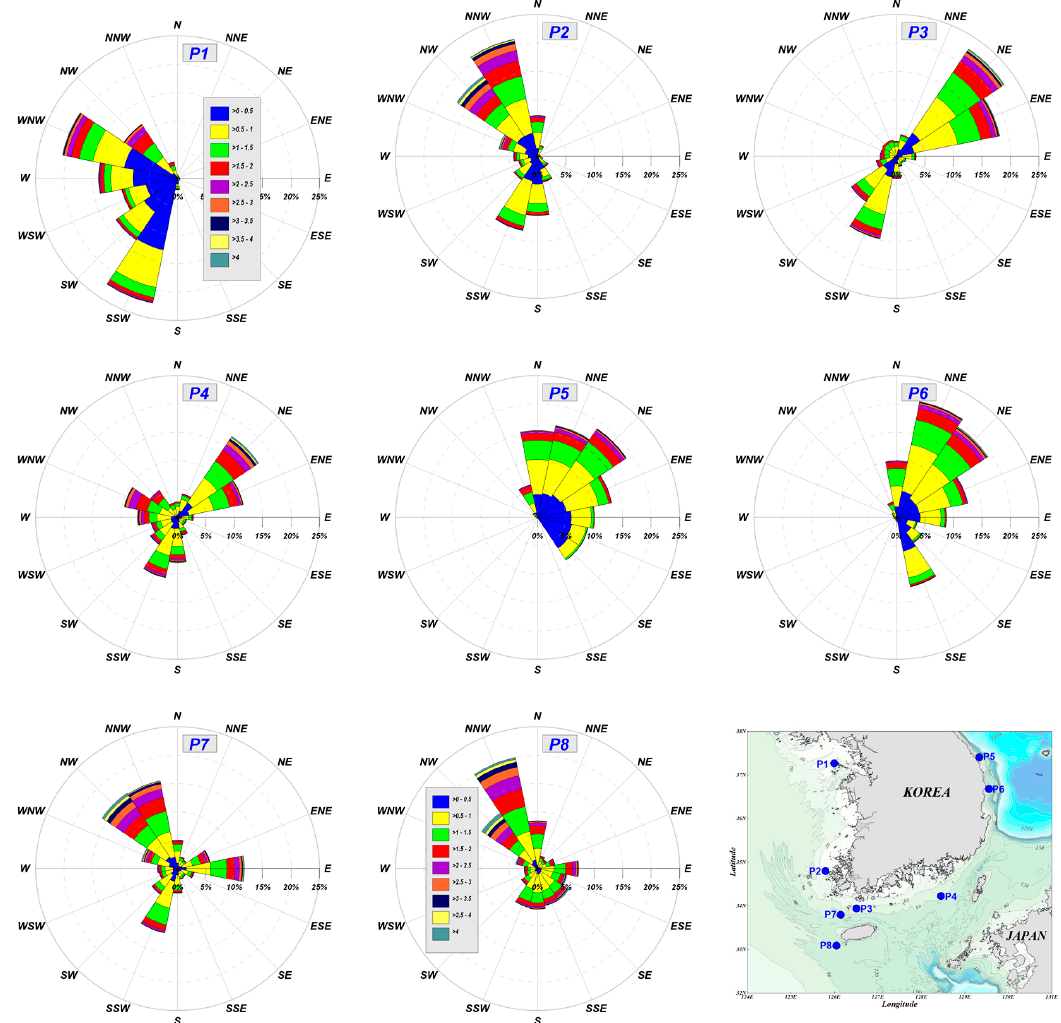
Figure 16. Rose diagram of averaged wave height and direction at eight selected locations in four regions around the Korean Peninsula over 2007–2018.